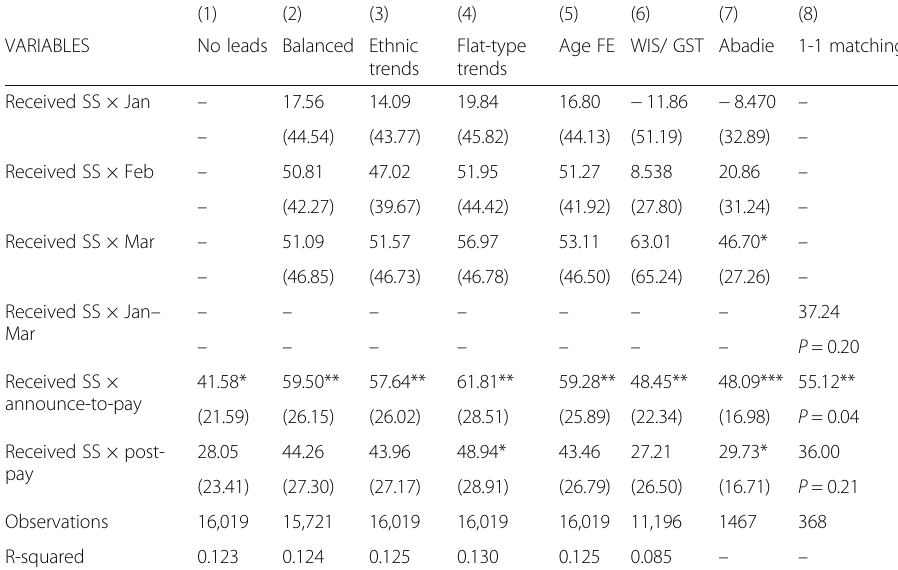
Table 28 Robustness check for impact of receiving SSS payouts on durables